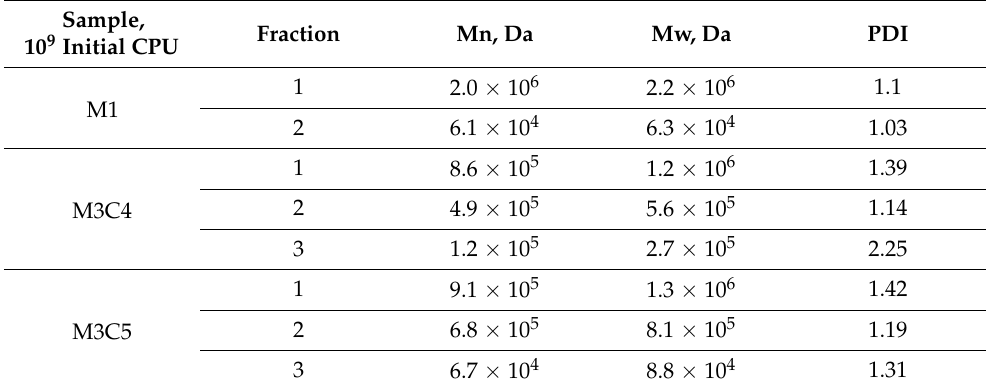
Table 2. Average molecular number (Mn), average molecular weight (Mw), and polydispersity index (PDI) of the biosynthesised